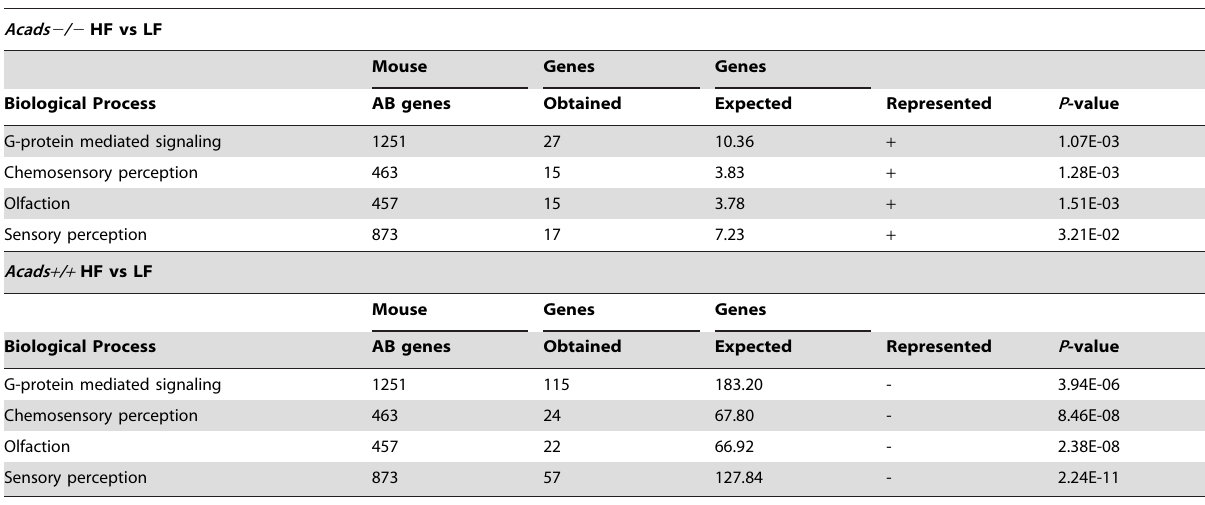
Table 5. Results of PANTHER analysis for olfactory and sensory genes.